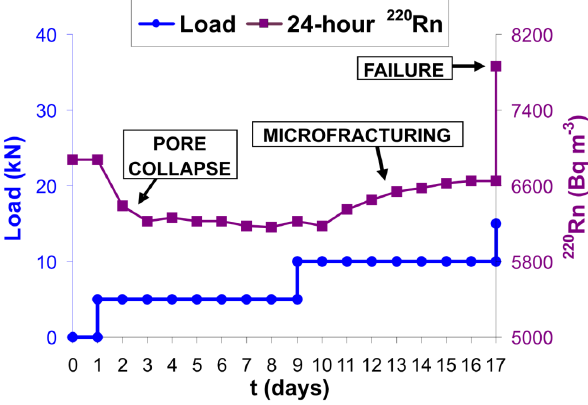
Figure 6. DDRC experiment R3, at constant temperatures of 90 ◦ C. The uniaxial load and 24h average 220 Rn activity concentration are plotted versus the experimental time. Two load steps from 0 to 5kN and from 5 to 10kN were performed. For each step the load was kept constant for 8 days. At 5kN, 220 Rn concentration decreases for 3 days. Then, the thoron activity achieved a new equilibrium value due to the attainment of a steady-state deformation condition where pore collapse was counterbalanced by microfracturing. When the load is increased to 10kN, microfracturing prevailed over rock densification and 220 Rn concentration progressively increased up to failure.